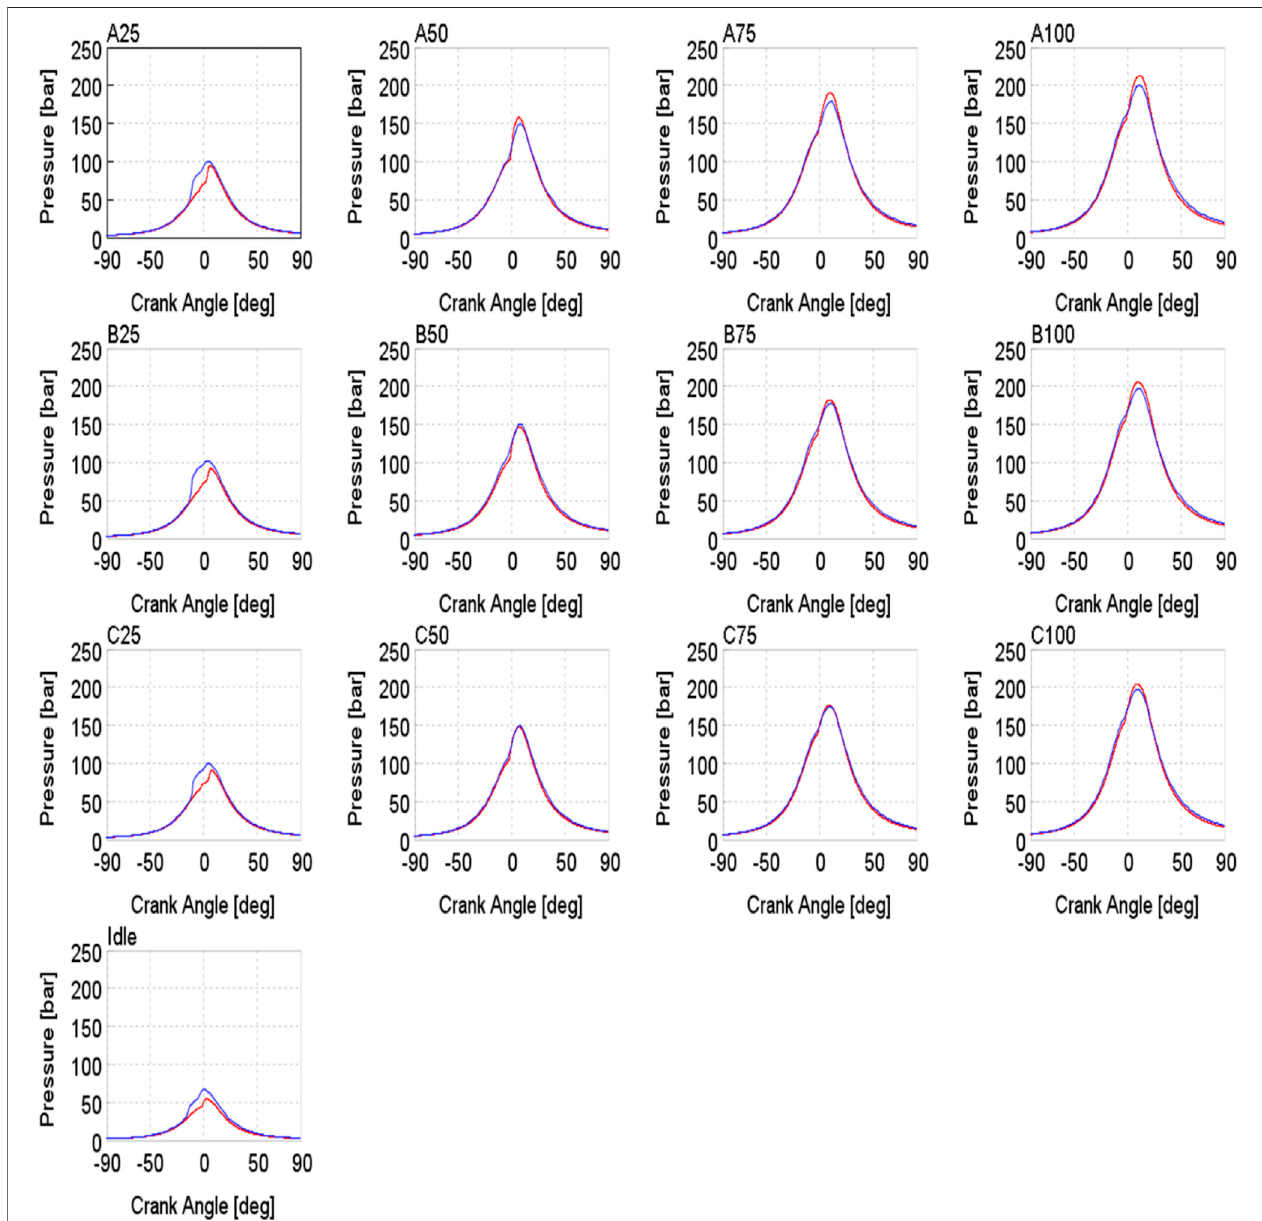
FIGURE 14 | Predictive ‘ DIJet ’ combustion model performance against GCI in-cylinder pressure traces over the 13-mode SET cycle.